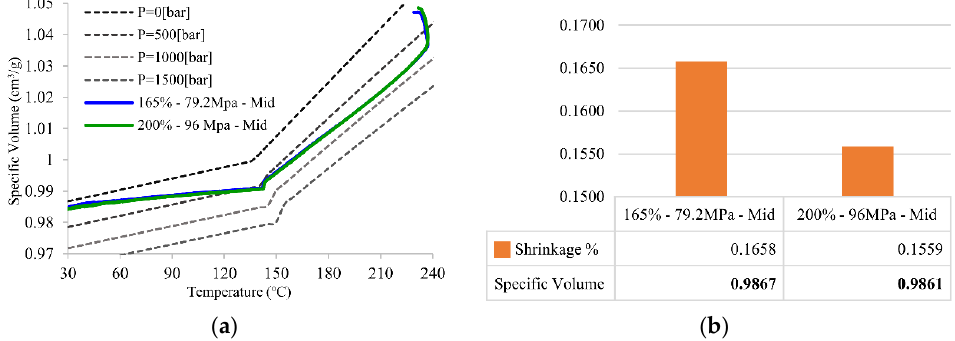
Figure 11. ( a ) PVT processing path of principle of intermittente packing pressure setup and ( b ) the final specific volume and its shrinkage for Mid section.